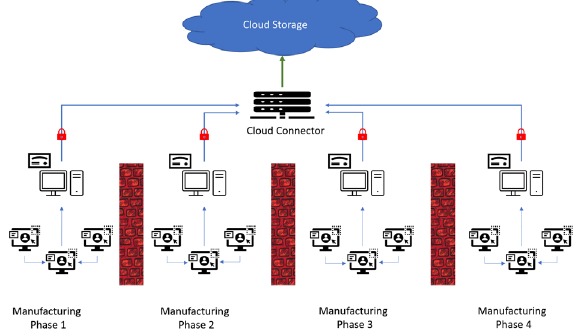
Figure 16. Zero-trust architecture for cloud-hosted data store .